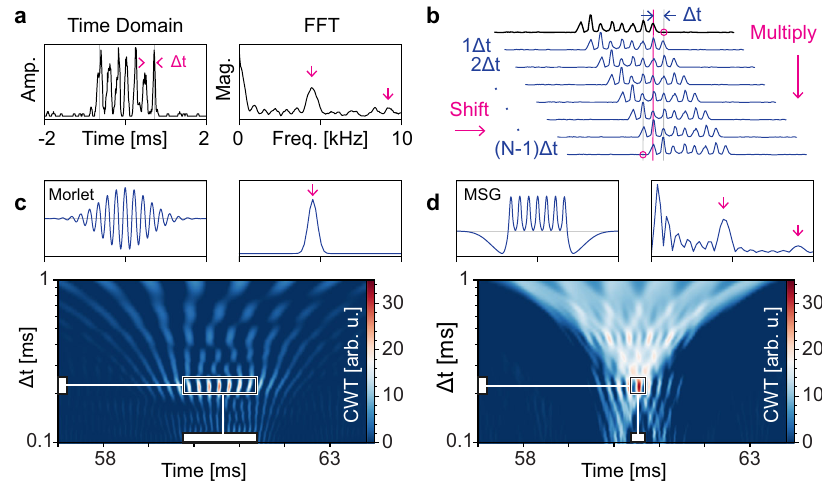
Fig. 3 Multi-peak detection methods. a Time and frequency domain representation of a fl uorescence signal taken from single K. pneumoniae Carbapenemase DNA molecules excited by seven excitation spots from the multi-mode interference (MMI) waveguide. Arrows in FFT indicate the fi rst and second harmonic of the time trace. b Shift-multiply algorithm previously used to fi nd and classify multi-peak signals. c Time and frequency information of Morlet wavelet with single component aligned to the fi rst harmonic of multi-peak signal. 2D map of positive CWT coef fi cients with white boxes indicating approximate certainty of time and scale localization. d Multi-spot Gaussian (MSG) wavelet designed to match the multi-peak signal as well as the full frequency spectrum; CWT coef fi cients map shows precise event